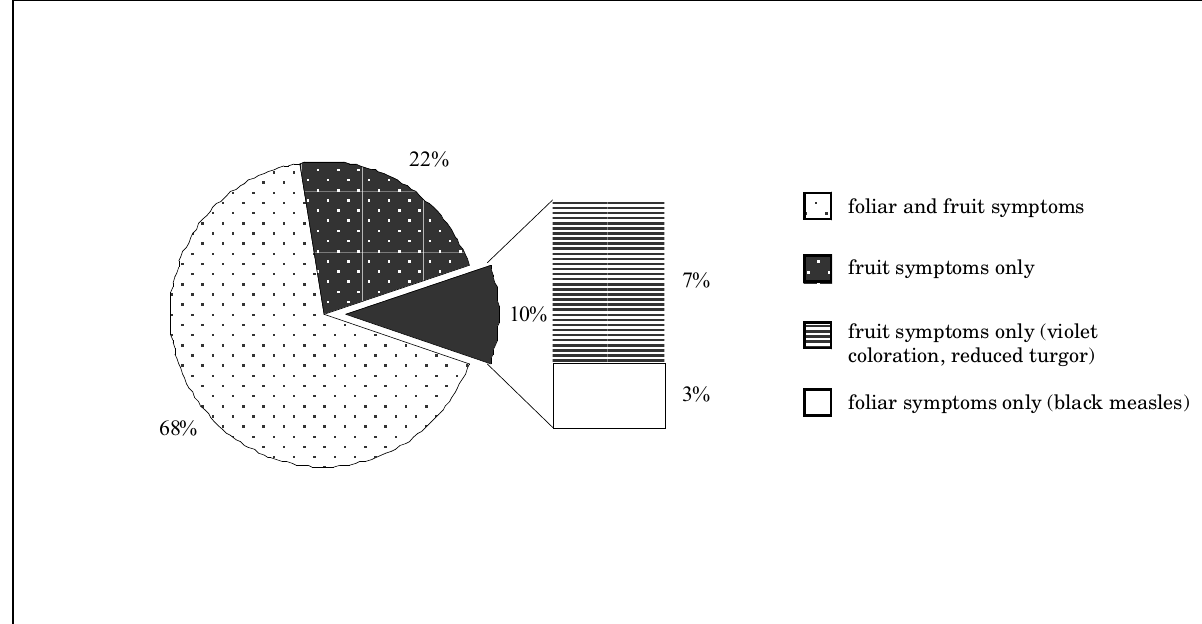
Fig. 5. Syndromes of esca in the Austrian vine-growing area of Kremstal in 1994. The symptoms of 134 diseased vines are classified by their mode of manifestation.